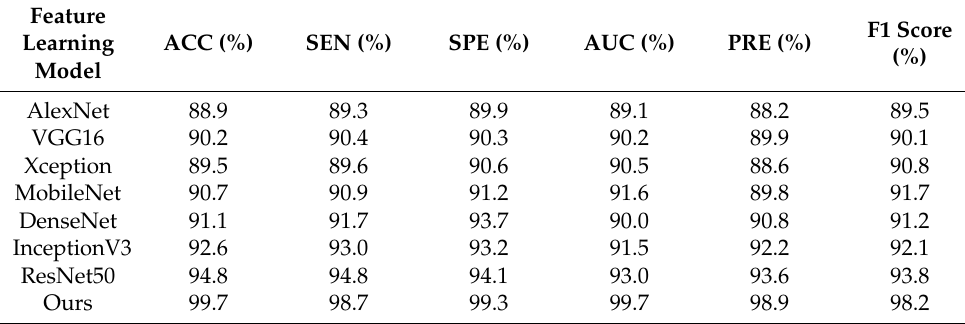
Table 7. Comparison of our proposed model with famous pre-trained feature extraction models for binary class using the dataset.